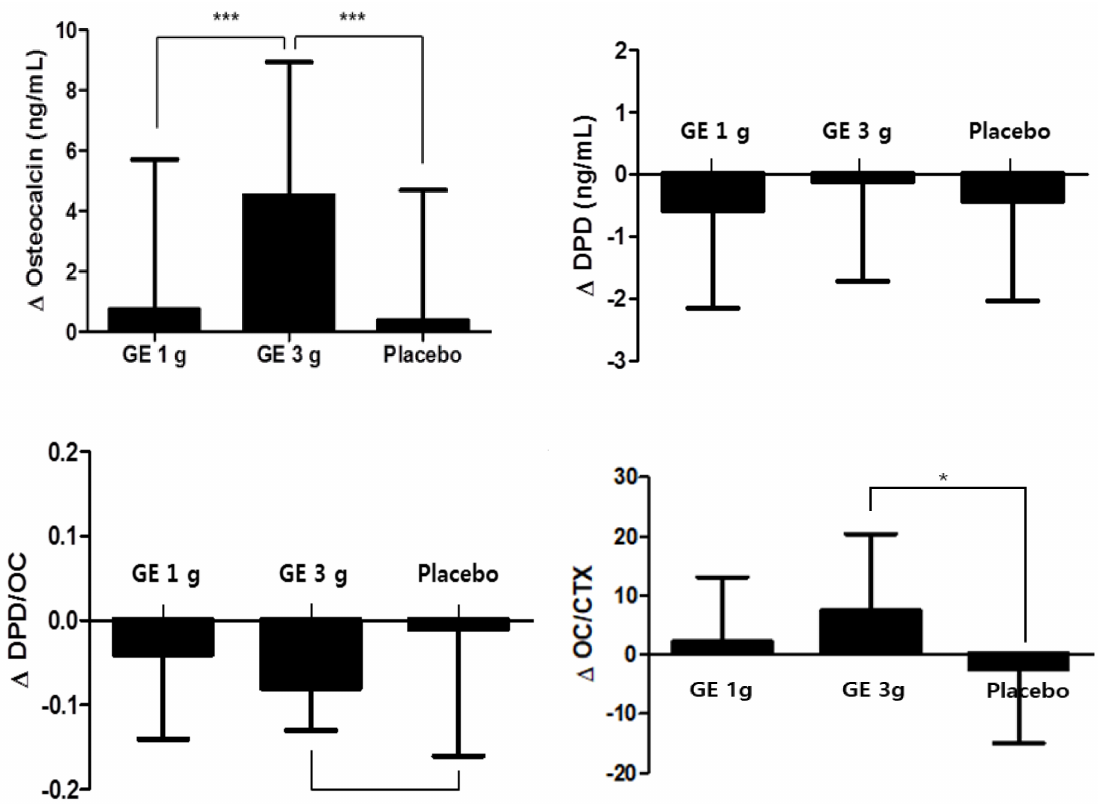
Figure 3. Changes in OC, DPD, DPD/OC ratio, and OC/CTX ratio of the subjects. There was a difference in the changes of the OC and DPD levels between the GE 1 g (low dose) and placebo groups. The DPD/OC and OC/CTX ratio was significantly decreased in the GE 3 g group (high dose) after 12 weeks. * p < 0.05, *** p < 0.001. Abbreviations: OC, Osteocalcin; DPD, deoxypyridinoline; CTX, C-terminal